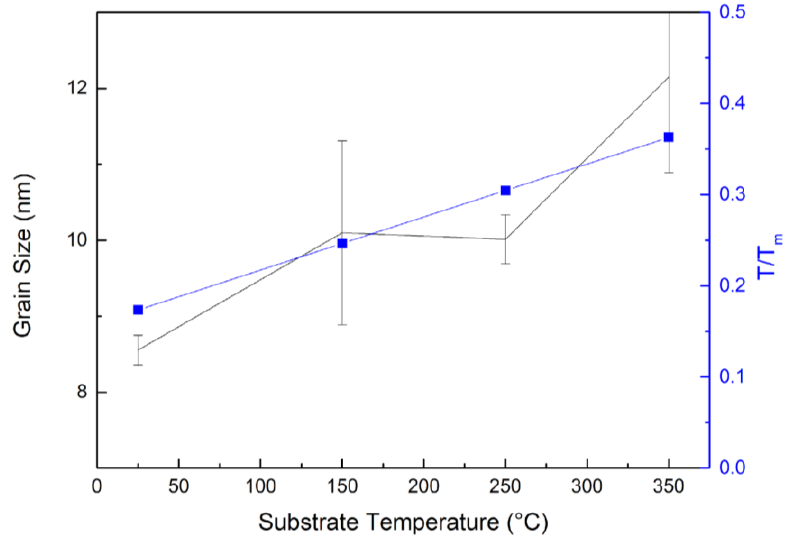
Figure 3. The relationship between grain size and substrate temperature (black line). The blue line indicates T/T m in terms of substrate temperature, where T is substrate temperature and T m is melting temperature of MEA.